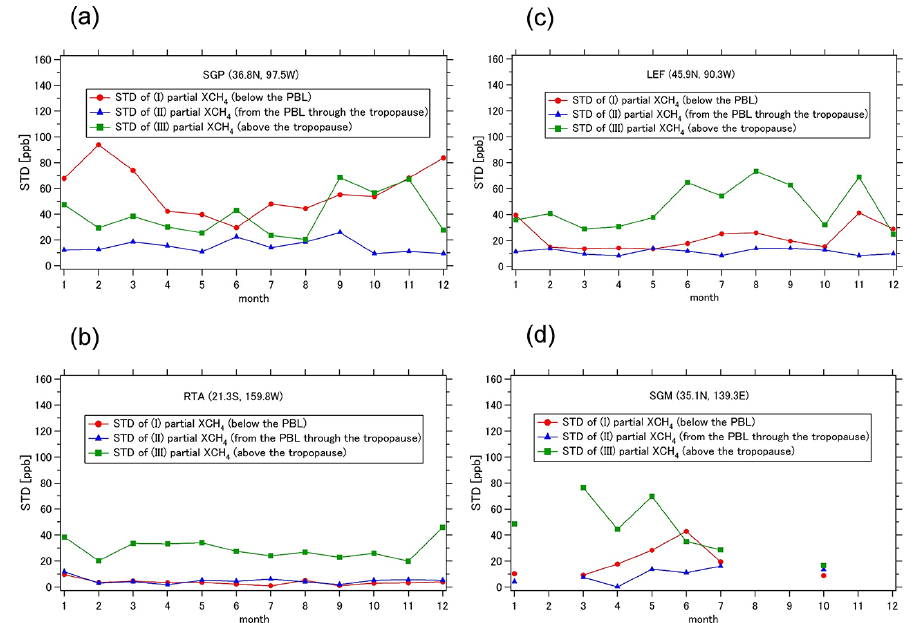
Figure 5. Monthly time series of the uncertainty of partial XCH 4 at (a) the Southern Great Plains (SGP), (b) Rarotonga (RTA), (c) Park Falls (LEF), and (d) Sagami Bay (SGM). Red circles, blue triangles, and green squares are monthly σ pbl , σ trp , and σ str , respectively.